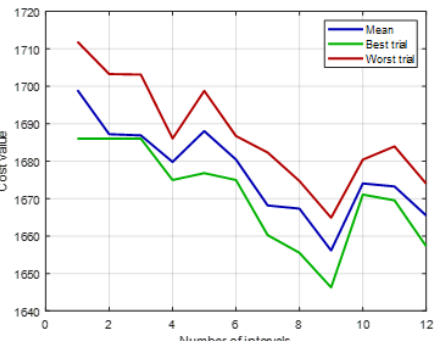
Figure 8. Mean, best, and worst daily operating cost attained by the optimal tuning of TRBH over 20 instances, as a function of the number of intra-day intervals.